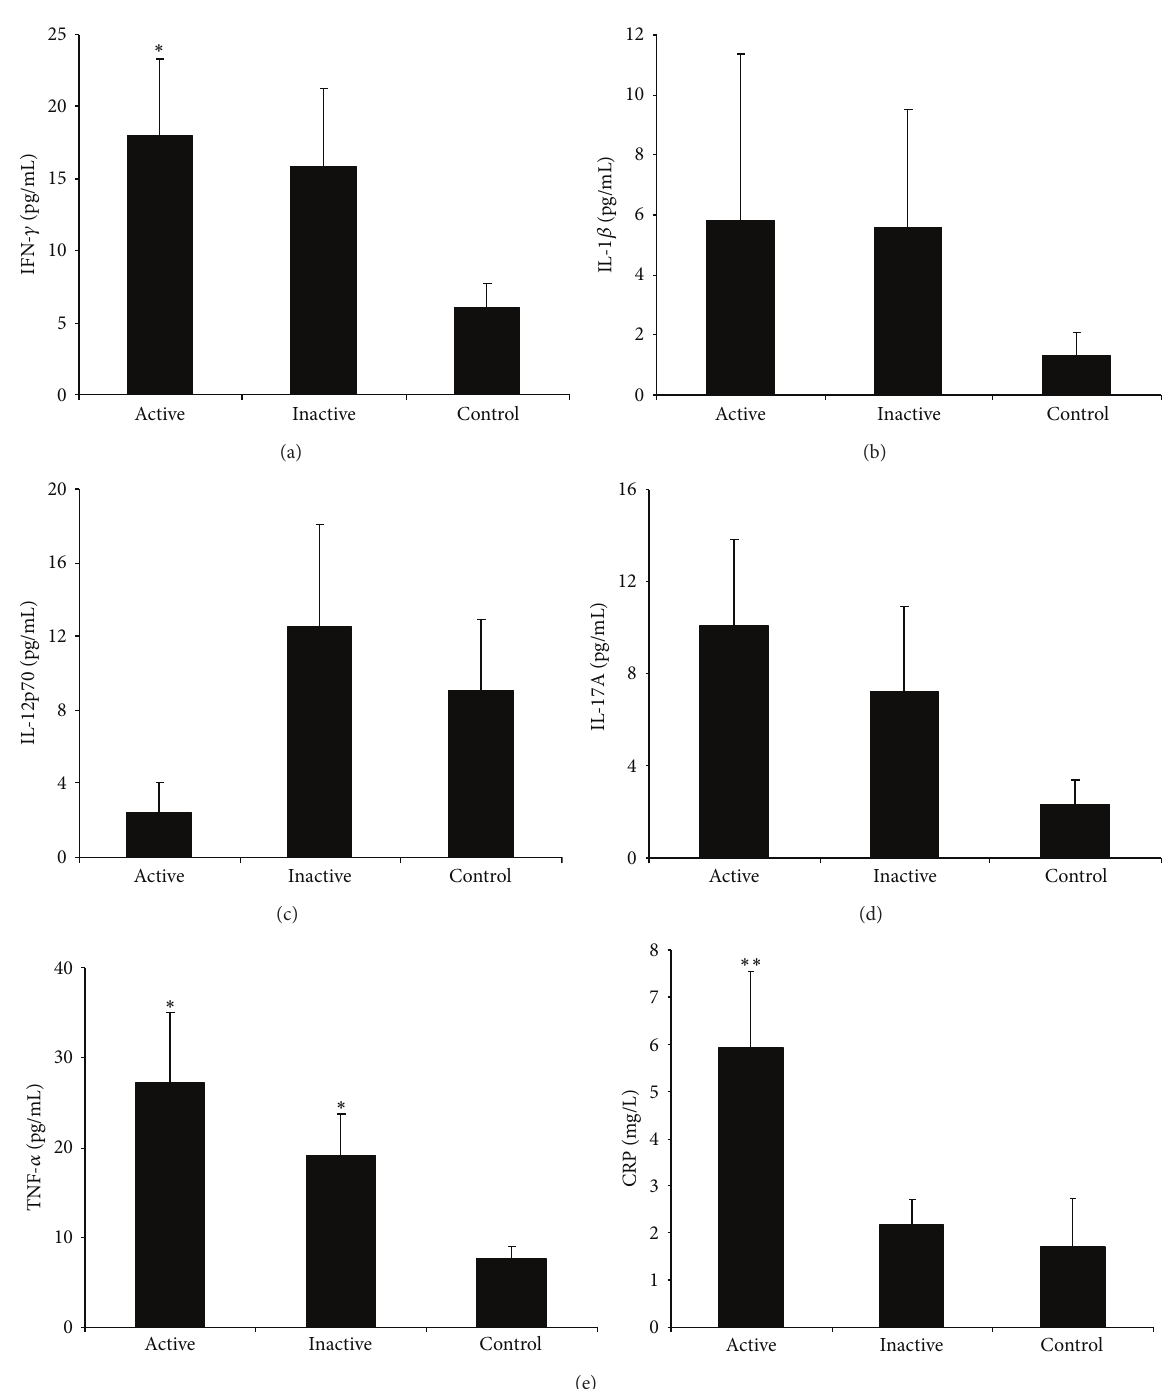
Figure 1: Cytokine profile and hsCRP levels of serum samples of patients with active BD ( 𝑁 = 13 ), inactive ocular BD ( 𝑁 = 24 ), and control subjects ( 𝑁 = 20 ). Results are expressed as mean values of cytokine levels (pg/mL) ± SEM. Statistical analysis was performed by Kruskal-Wallis test ( ∗ 𝑃 < 0.05 versus control; ∗∗ 𝑃 < 0.05 versus control and